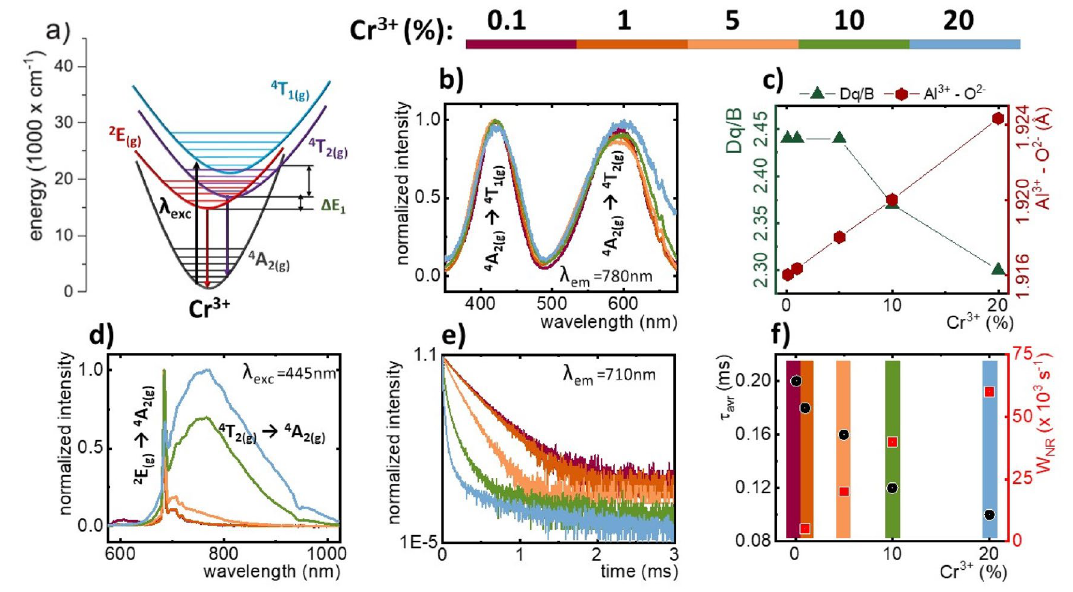
Figure 2. Simplified energy level diagram of Cr 3+ ions—( a ); normalized excitation spectra upon monitoring the emission at 780 nm—( b ), dependence of Dq/B parameter and Al 3+ –O 2− ionic distance as a function of Cr 3+ concentration—( c ), comparison of emission spectra upon excitation at 445 nm—( d ) luminescence decay curves at RT with emission monitored at 710 nm (λ exc 445 nm)—( e ) for YAl 3 (BO 3 ) 4 :Cr 3+ nanocrystals; probability of nonradiative processes (W NR ) as a function of Cr 3+ concentration—( f